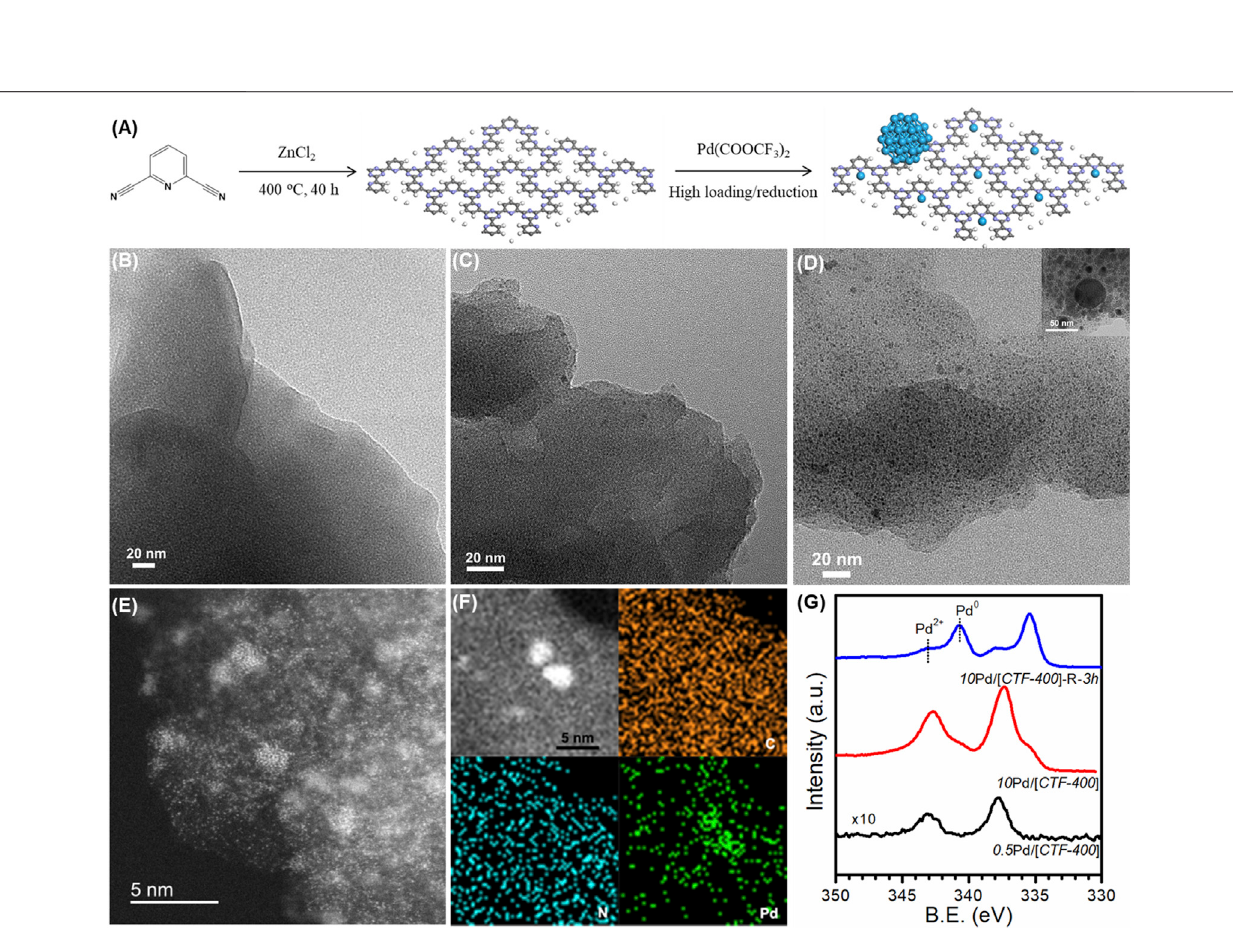
Frontiers in Chemistry |